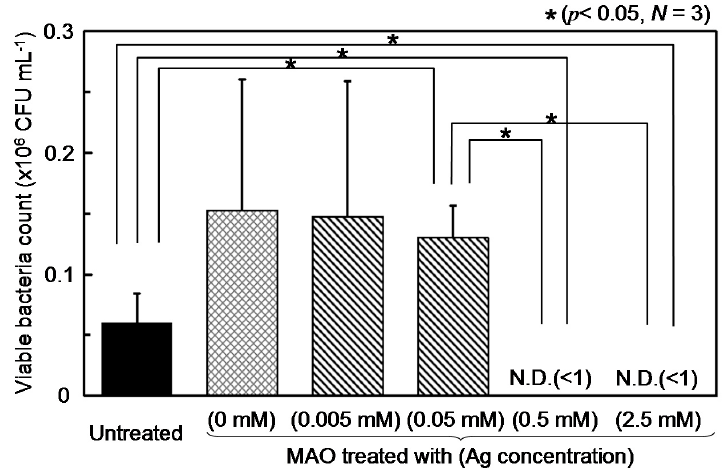
Figure 3. Result of bacterial adhesion test using E. coli on TNTZ specimens.